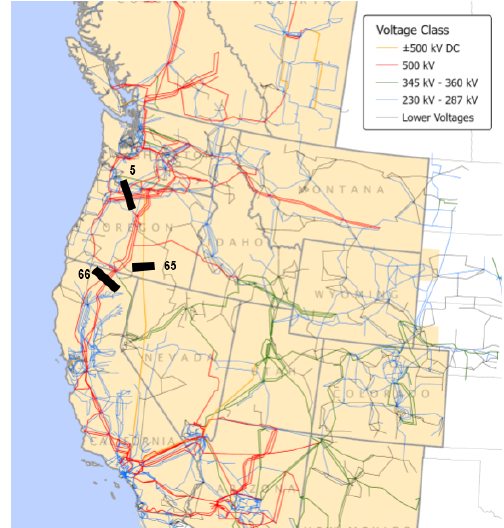
Figure 10. Relevant WECC paths in Oregon [29]. This analysis considers path 5, path 14 (not indicated on this map), path 65, and path